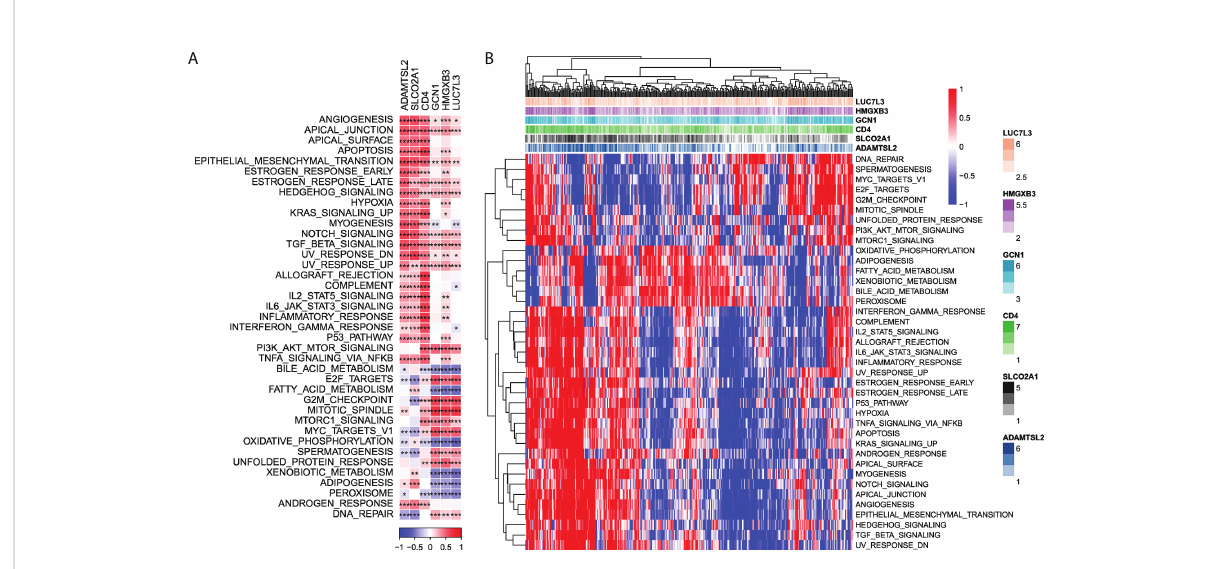
FIGURE 6 Identi fi cation of pathways that the risk genes involved in. (A) Gene-pathway correlation heatmap; (B) Enrichment score heatmap for key pathways. *P < 0.05, **P < 0.01, ***P <